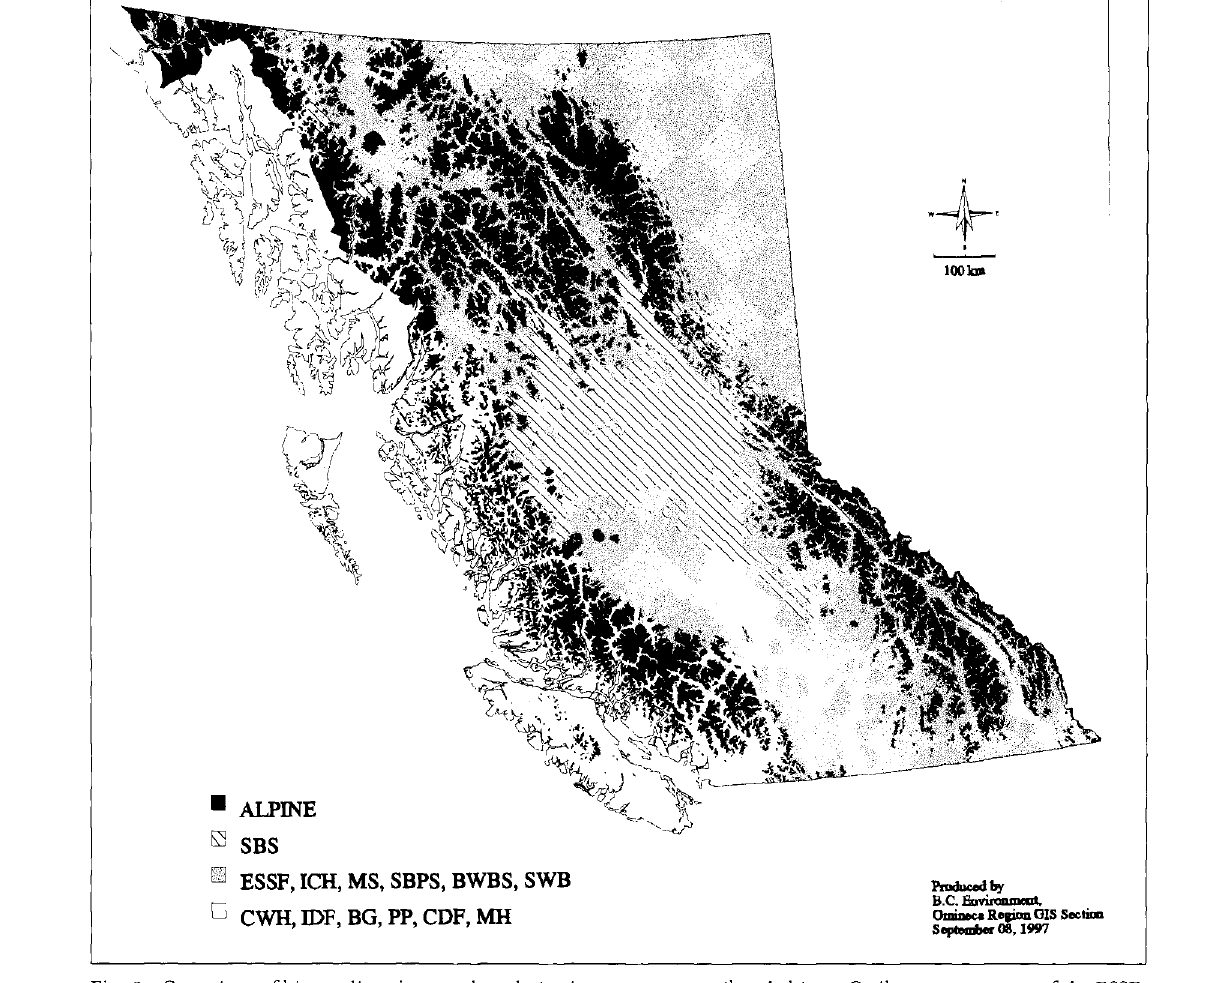
Fig. 2. Groupings of biogeoclimatic zones by relative importance as caribou habitat. Caribou occupy most of the ESSF, ICH, MS, SBPS BWBS SWB and the adjacent Alpine Tundra and, formerly, also occupied the SBS. See the text for names of the biogeoclimatic